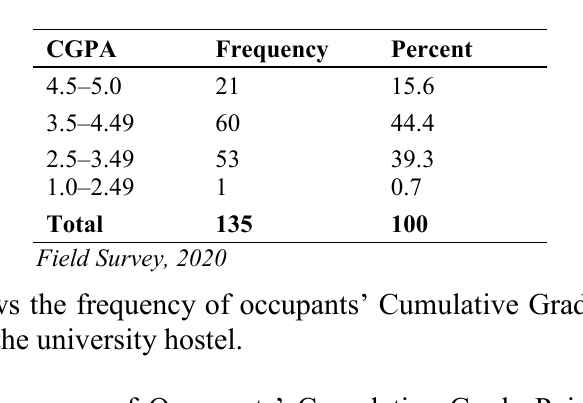
Table 7. The Frequency of Occupants’ Cumulative Grade Point Average after Moving to the University Hostel